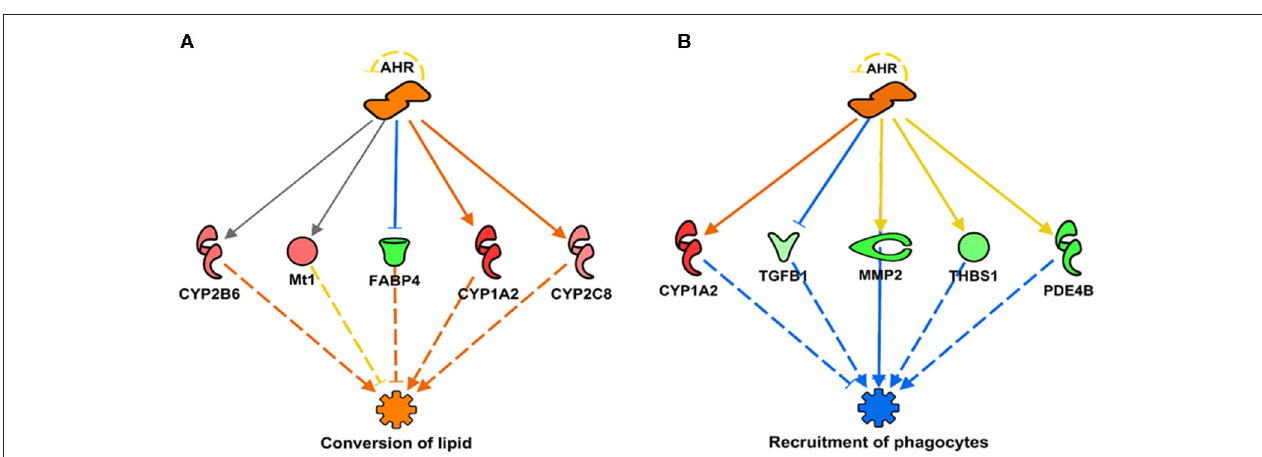
FIGURE 3 | Regulator networks illustrating the role of aryl hydrocarbon receptor (AHR) as the master regulator in a component of lipid metabolism and inflammatory response. (A) Conversion of lipid ( Z -score = 2.09, p = 2.77 × 10 − 08 ), predicted to be activated in SPI diet; (B) recruitment of phagocytes ( Z -score = –2.31, p = 2.10 × 10 − 05 ), predicted to be inhibited. Both networks have in common the upregulation of CYP1A2 as indirect result of AHR activation (activation Z -score = 2.15, p = 4.20 × 10 − 11 ). Genes in pink or red were upregulated in the SPI-fed rats, whereas those in green were downregulated in SPI- vs. CAS-fed rats. Gene names and fold differential expression in the regulatory networks are CYP1A2 (Cytochrome P450 Family 1 Subfamily A Member 2, 2.11), FABP4 (Fatty Acid Binding Protein 4, − 1.91), CYP2B6 (Cytochrome P450 Family 2 Subfamily B Member 6, 1.51), Mt1 (Metallothionein 1, 1.52), CYP2C8 (Cytochrome P450 Family 2 Subfamily C Member 8, 1.41), TGFB1 (transforming growth factor beta 1, – 1.33), MMP2 (matrix metallopeptidase 2, – 1.96), PDE4B (phosphodiesterase 4B, – 1.93), and THBS1 (thrombospondin 1, – 1.63).